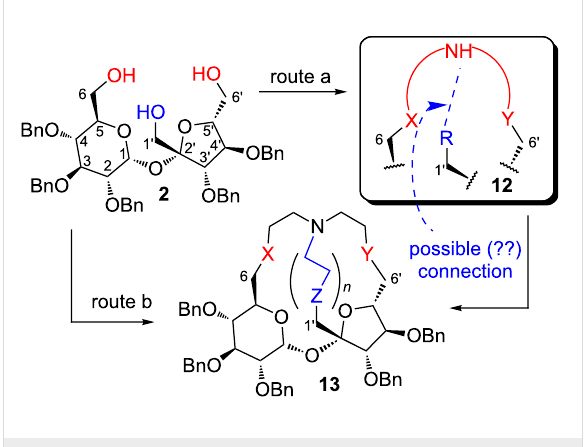
Figure 3: A concept for synthesis of a cryptand from penta- O -benzyl- sucrose ( 2